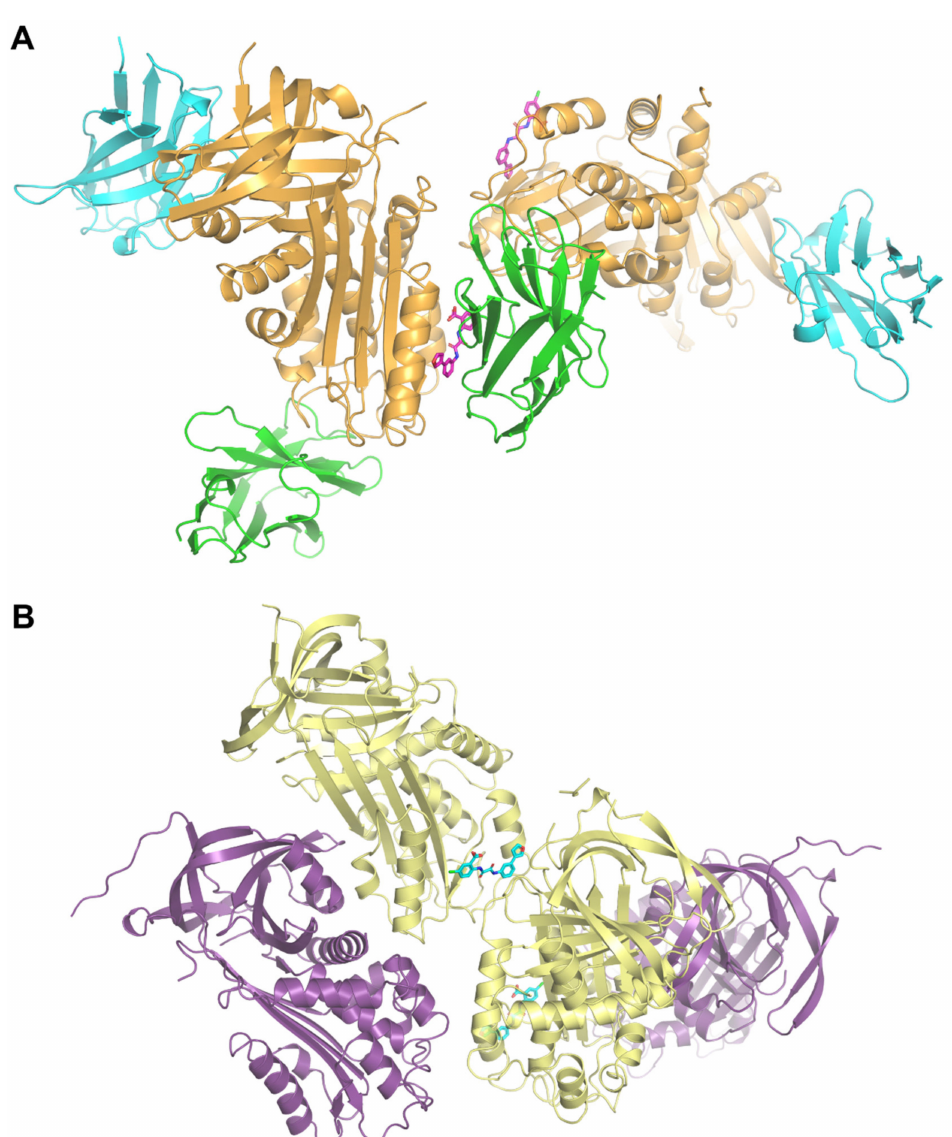
Figure 4. Cartoon representation of the PAI-1/TM5484 complexes. ( A ) In the case of the two PAI-1-W175F/Nb42/Nb64 crystals, TM5484 is located in the same orientation at the crystallographic interface between one PAI-1 molecule and an Nb64 molecule of the neighboring ASU. PAI-1 is shown in orange, Nb42 in cyan, Nb64 in green and TM5484 in magenta. ( B ) The ASU in the PAI-1-stab crystal comprises two PAI-1-stab molecules and one TM5484 compound associated with one of the two PAI-1 molecules. TM5484 is located at the crystallographic interface between one PAI-1 molecule of ASU 1 and one PAI-1 molecule of a neighboring ASU. PAI-1 molecules inside one ASU are shown in yellow and purple. TM5484 is shown in